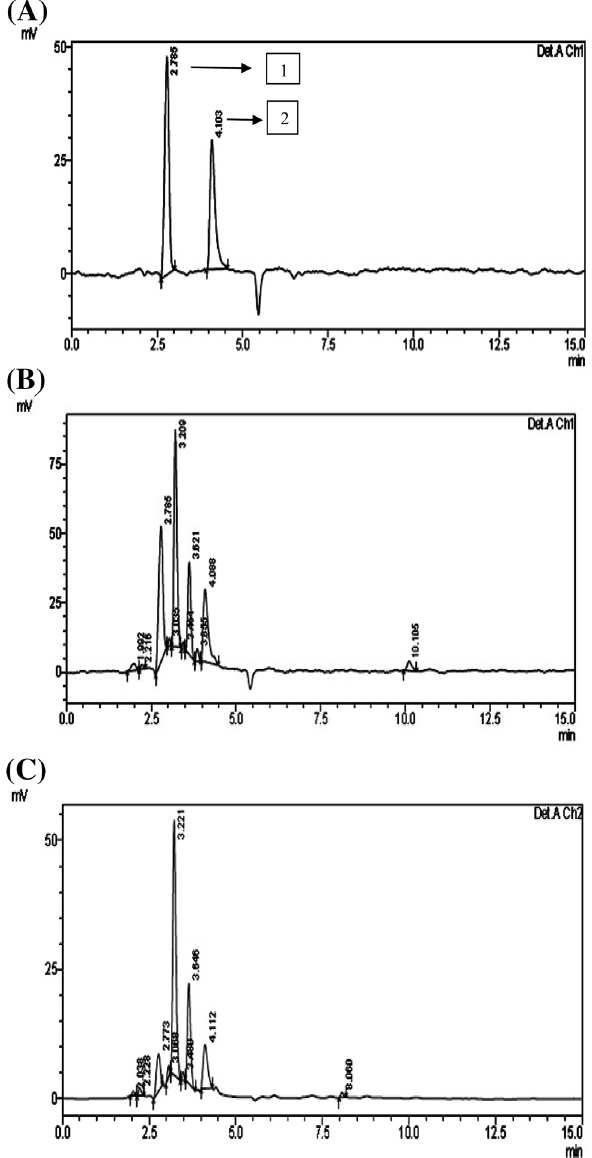
Fig. 3 HPLC chromatogram for a authenticated phenolic com- pounds. 1: 4-hydroxy-3-methoxybenzoic (vanillic) acid and 2: 4-hydroxy-3,5-dimethoxybenzoic (syringic) acid, b chromatogram of different inhibitors in alkali-pretreated saw dust and c chro- matogram of inhibitors during the delignification of biologically pretreated saw dust with laccase from Trichoderma harzianum strain